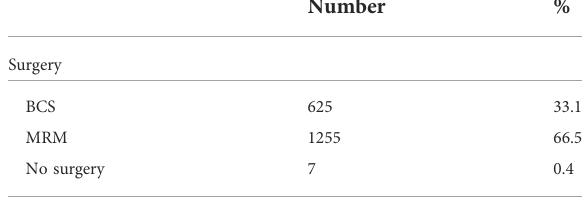
TABLE 1 The clinicopathological characteristics of the breast cancer patients enrolled in this